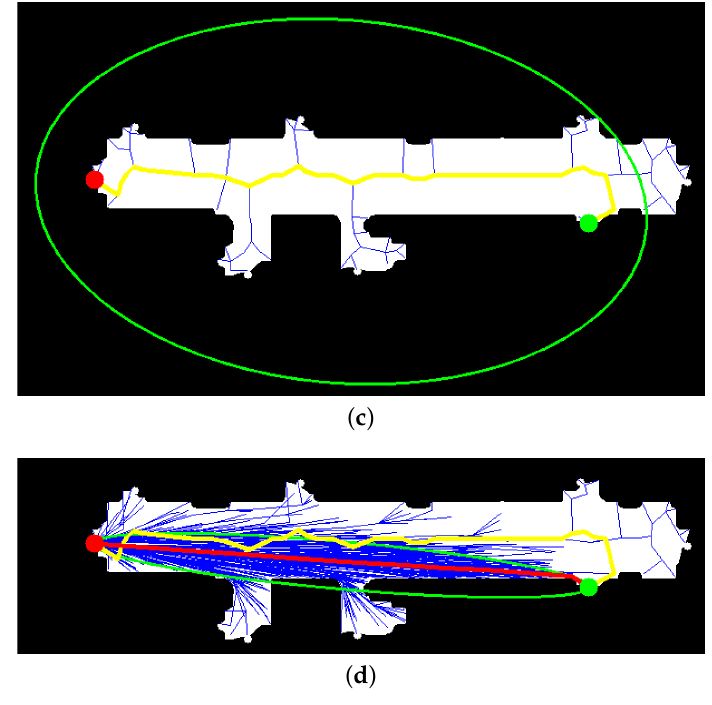
Figure 4. An example of local path-planning for Segment “9” using the skeletonization informed rapidly exploring random tree* (SIRRT*): ( a ) Skeletonization of the grid map segment. ( b ) Local nodes (blue dots) extracted by the Harris corner detector; the red dot is the start position; the green dot is the goal. ( c ) The initial tree (blue line) and the initial path (yellow line). ( d ) The final tree (blue line) and the optimized path (red